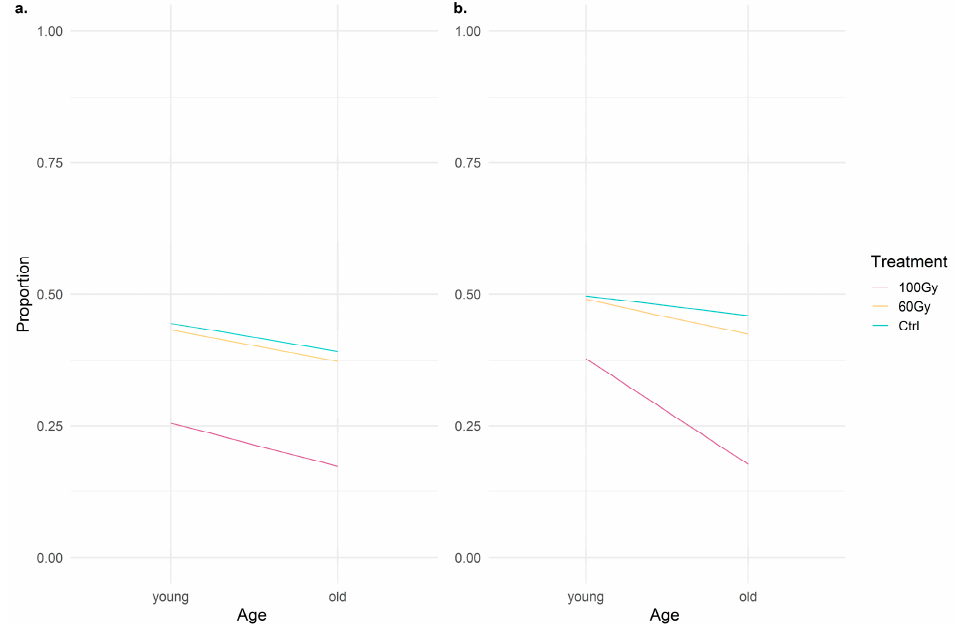
Figure 7. Line plots describing at all three doses the probability of the occurrence of ( a ) behavior 1 (i.e., no mating or mating) and ( b ) behavior 2 (i.e., Mount or Mating) between young and old